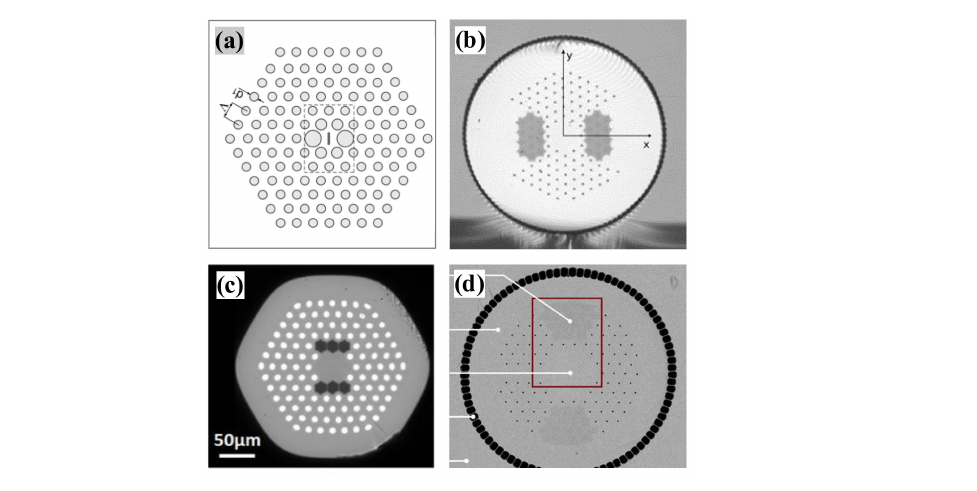
Figure 7. ( a ) (2008) Wroclaw University of Technology introduced small holes in the central region of the core to induce birefringence; ( b ) (2013) NKT fabricated fiber named DC-200/40-PZ-Yb [58]; ( c ) (2015) Clemson University developed single-polarized, single-mode operating Yb-polarized all- solid-state photonic bandgap fiber [11]; ( d ) (2008) 54 µ m mode field diameter reported by Crystal Fiber A/S